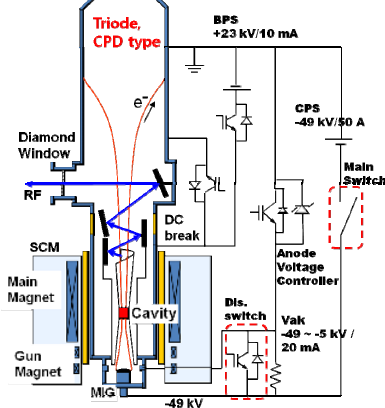
Fig. 1 . 170 GHz, 1 MW gyrotron and the configuration of the power supply system